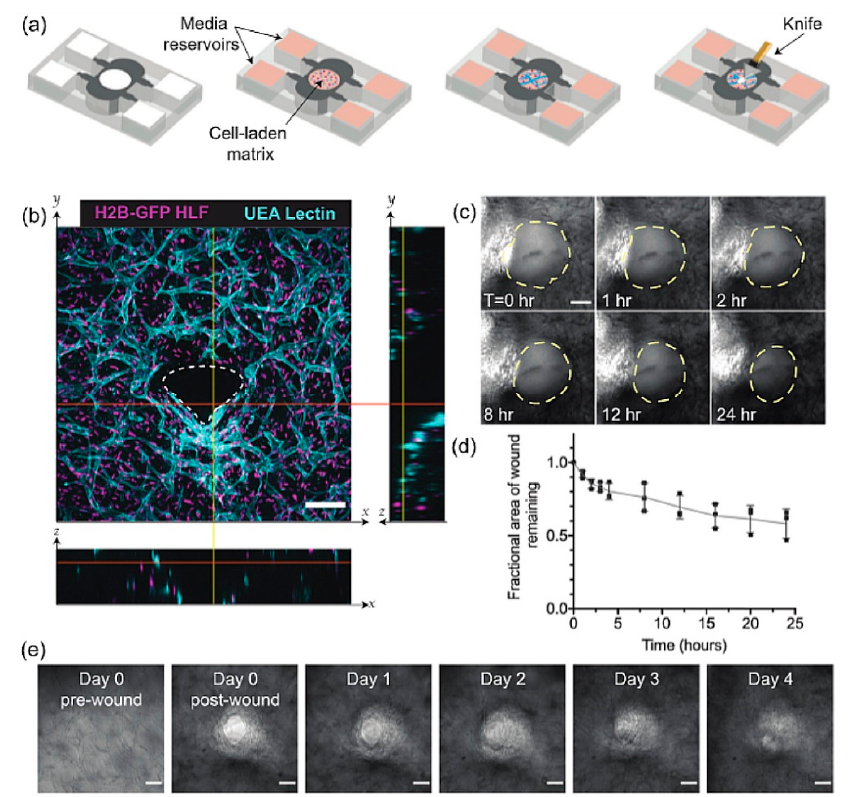
Figure 3. Damaged 3D exogenous dermis equivalent: ( a ) Schematic representation of the experimental design: endothelial cells and fibroblasts embedded in a fibrin gel are inserted in a PDMS device. The 3D vascularized tissue is allowed to mature for 3 days before cutting with a diamond knife, ( b ) Immunofluorescence image of the wounded vascularized tissue one day after cutting. Z-projection, both in x-z and y-z coordinated, indicates the wound depth and white dotted lines delineate wound boundaries, ( c ) 24 h-brightfield time-lapse acquisitions with wound borders highlighted by yellow dotted lines, ( d ) Quantification of wound area reduction over 1 day, ( e ) Brightfield images of the tissue up to wound closure day (day4). Reproduced under the terms of the CC BY 4.0 license from Tefft JB, Chen CS, Eyckmans J. Reconstituting the dynamics of endothelial cells and fibroblasts in wound closure, 2021;016102. [71] Copyright © 2021, The Author(s); published by AIP Publishing.